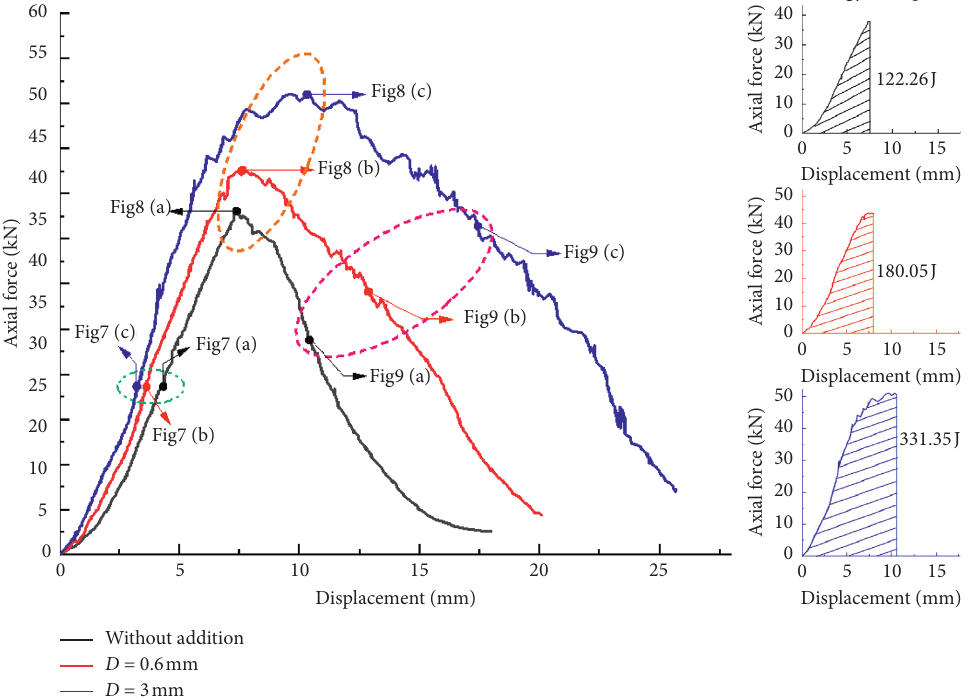
Figure 10: Axial force-displacement curves of different types of resin grout.